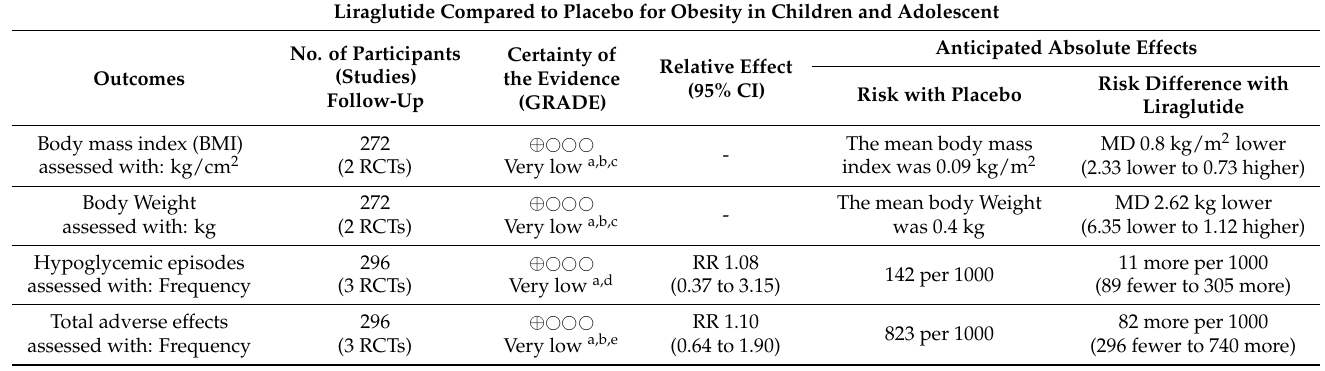
Table 2. Summary of findings, GRADE certainty of